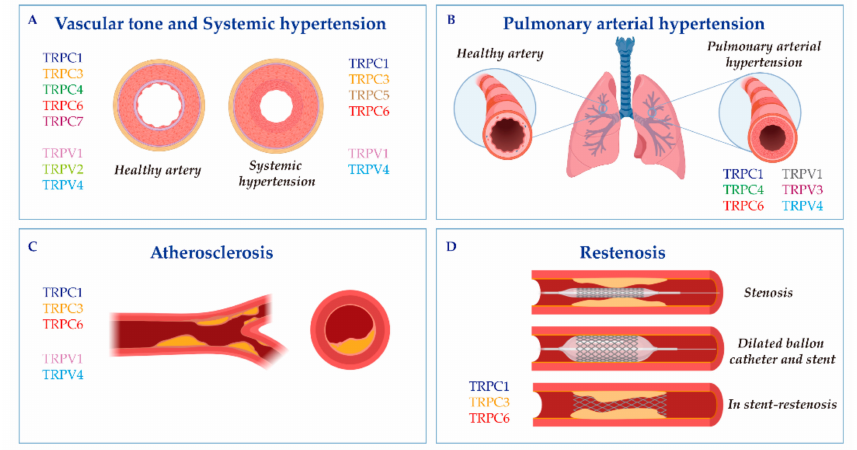
Figure 1. The cartoon indicates Transient receptor potential canonical (TRPC) and vanilloid (TRPV) isoforms involved in ( A ) vascular tone and systemic hypertension; ( B ) pulmonary arterial hypertension; ( C )atherosclerosis; and( D )restenosis. VascularresponsesanddisordersdependeitheronTRPactivation in the endothelium and vascular smooth muscle cells, or on critical changes in their